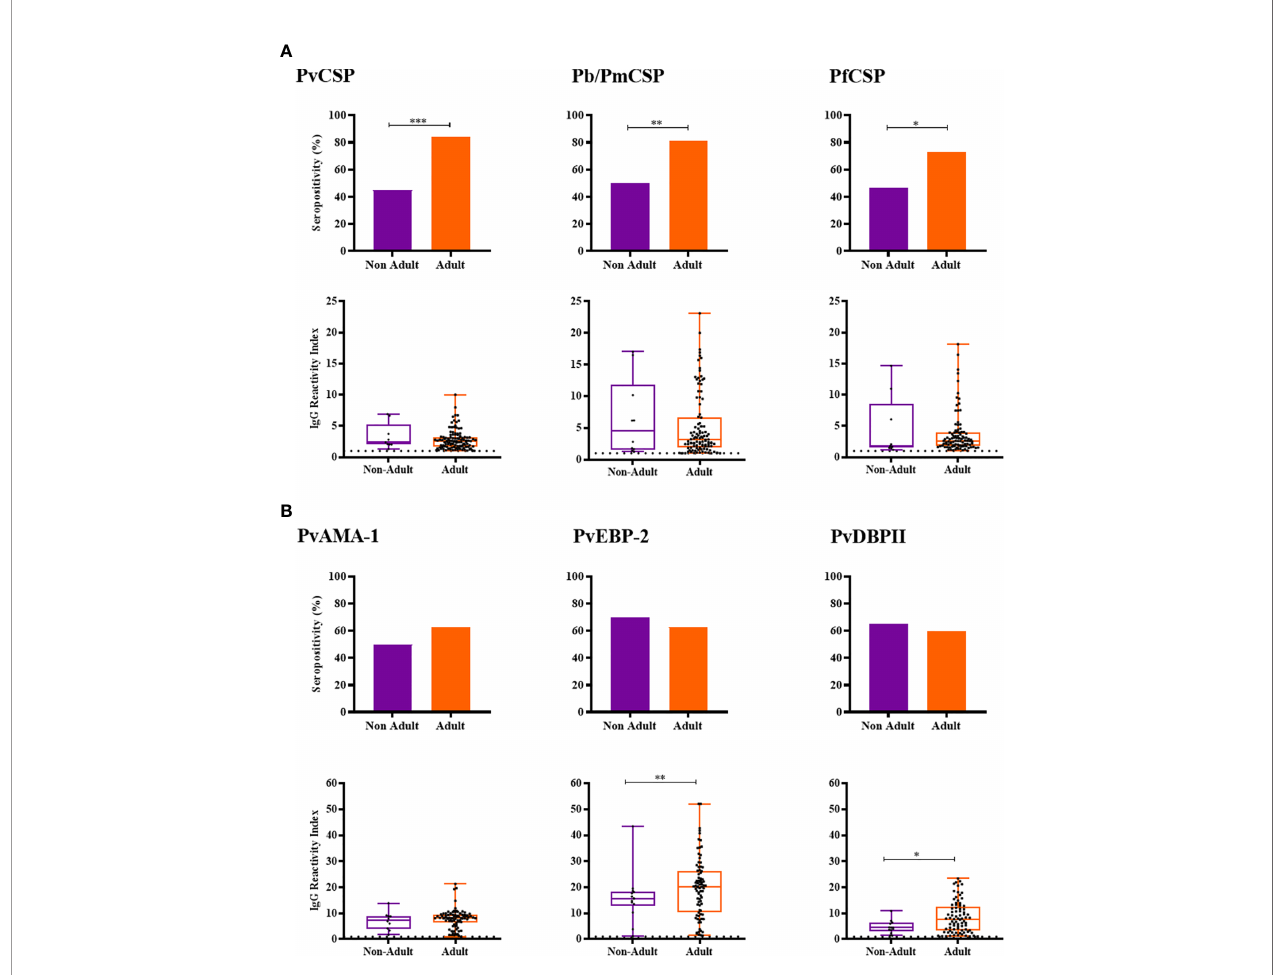
FIGURE 4 | Prevalence and levels of antibodies against Plasmodium antigens according to age of neotropical primates. (A) Seropositivity and reactivity index (RI) of IgG antibodies against CSP peptides. (B) Seropositivity and RI of IgG antibodies against Plasmodium vivax erythrocytic antigens. RI > 1 was considered positive (dotted line). The fi lled bars indicate the percentage of NP with RI > 1 ( A , B top). Data expressed as individual RI values (dots) and median with the interquartile range (boxes) ( A , B botton). Age estimated according to Carpenter, 1965, and categorized in non-Adult (light purple) and Adult (orange). PvCSP: CSP repeats representing P. vivax CSP variants (VK210, VK247, and P. vivax-like ); Pb/PmCSP: CSP repeat of P. brasilianum/P. malariae ; PfCSP: CSP repeat of P. falciparum ; PvAMA-1: P. vivax Apical membrane antigen – 1; PvEBP-2: P. vivax Erythrocyte Binding Protein 2; PvDBPII: P. vivax Duffy Binding Protein region II. Differences statistically signi fi cant were indicated by asterisk (* P < 0.05; ** P < 0.01; *** P <